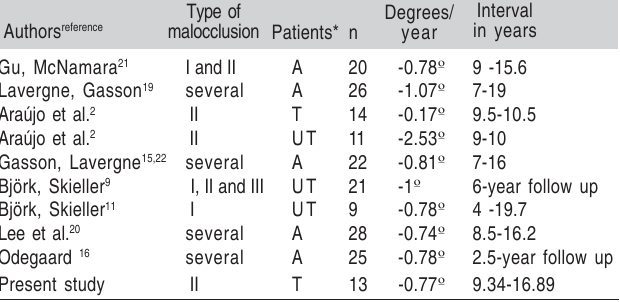
Table 7 . Yearly changes in the mandibular total rotation in studies on metallic implants – available data.